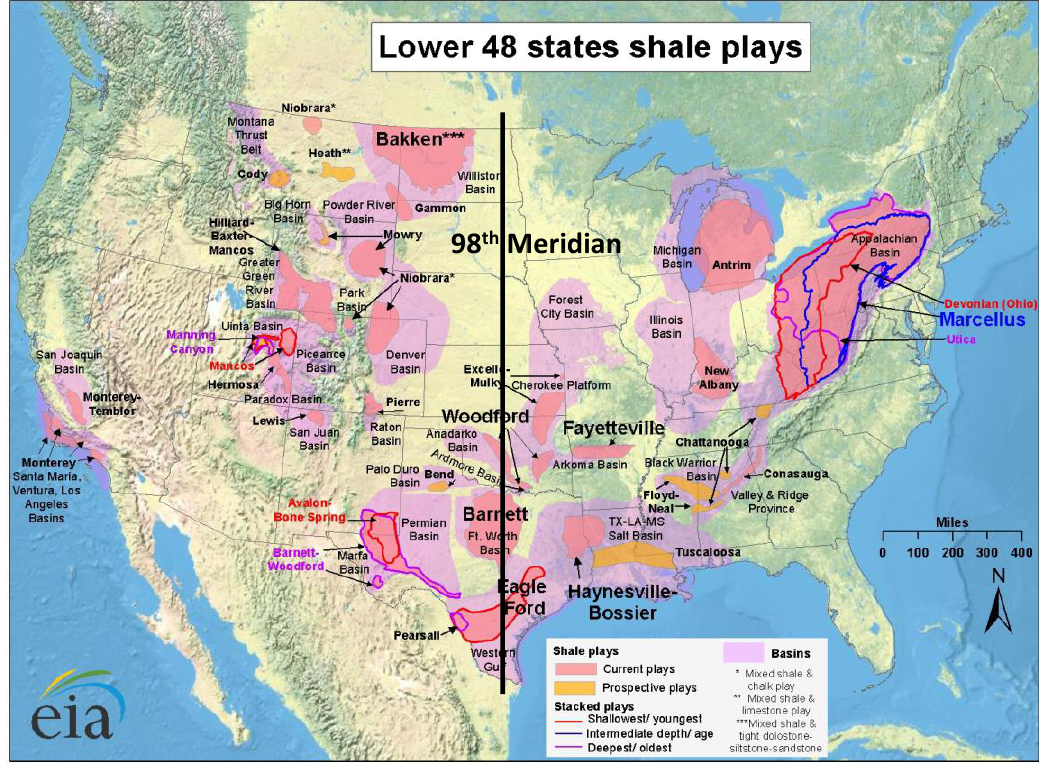
Figure 3. Major oil and gas production regions in the U.S. with 98th meridian. Source: U.S. Energy Information Administration [34].